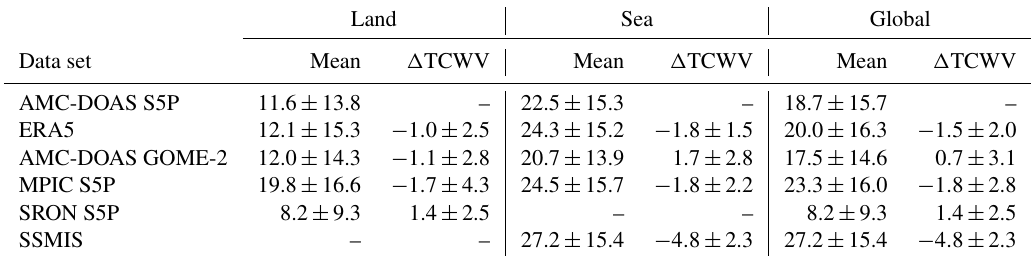
Table 3. Global average ( ± standard deviation) of the TCWV products and average difference to the AMC-DOAS S5P TCWV product ( (cid:49) TCWV) for January 2019 in kilograms per square metre (kgm − 2 ).